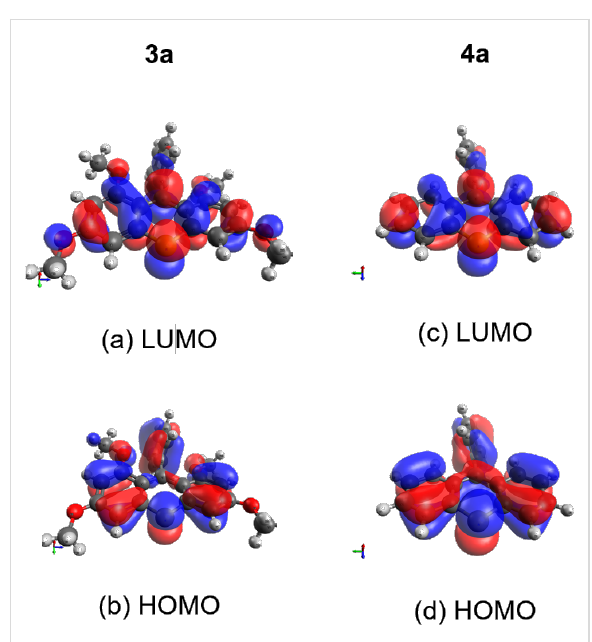
Figure 3: Frontier orbitals of thioxanthylium salts, calculated by DFT at the B3LYP/6-31G(d,p) level of Orca. (a) LUMO localization of 3a (energy level: − 5.745 eV), (b) HOMO localization of 3a (energy level: − 8.842 eV), (c) LUMO localization of 4a (energy level: − 6.812 eV), (d) HOMO localization of 4a (energy level: − 9.788